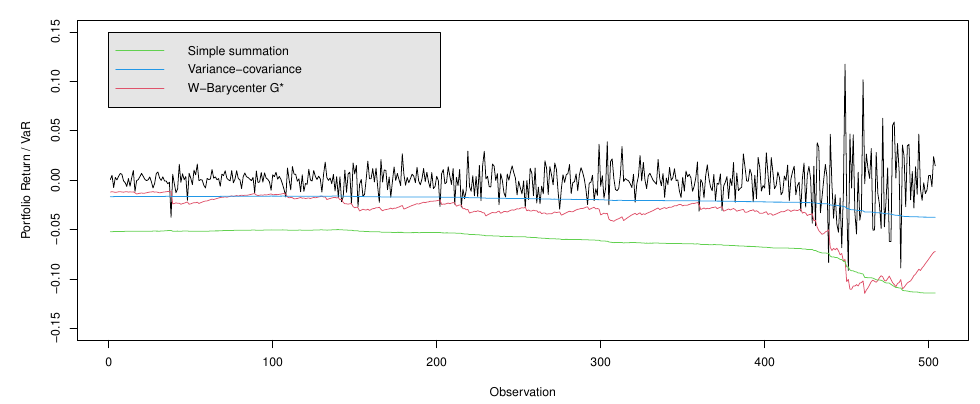
Figure 2. Daily Return series and VaR during the global financial crisis